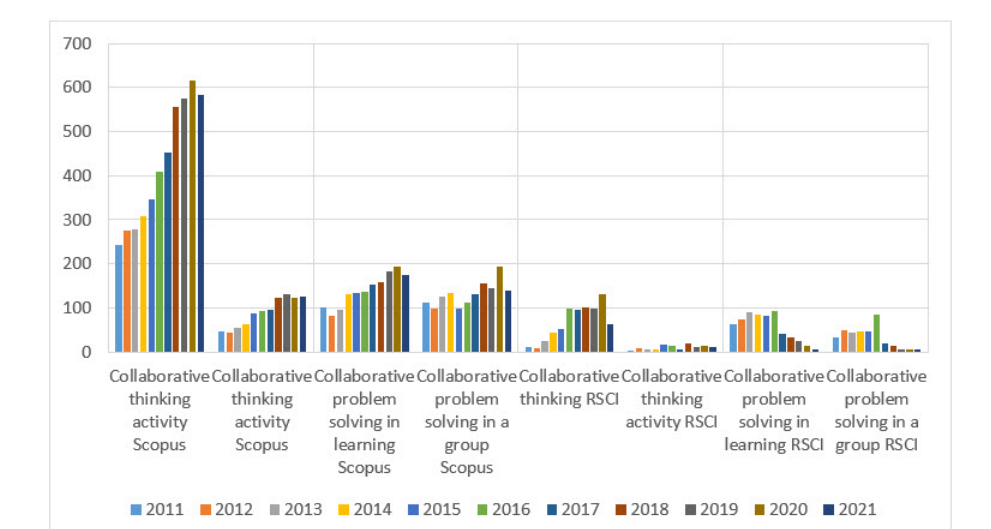
Figure 2. Distribution of publications in the Scopus and the Russian Science Citation Index